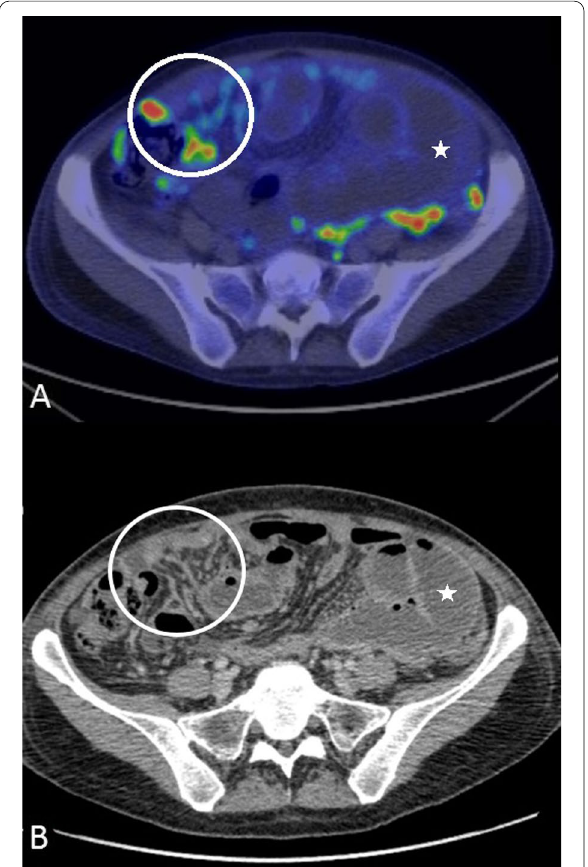
Fig. 14 a , b : a PET-CT and ( b ) CT images of a patient with epithelioid malignant peritoneal mesothelioma showing nodular mesenteric fold thickening (white circle) and segmental small bowel obstruction(*)